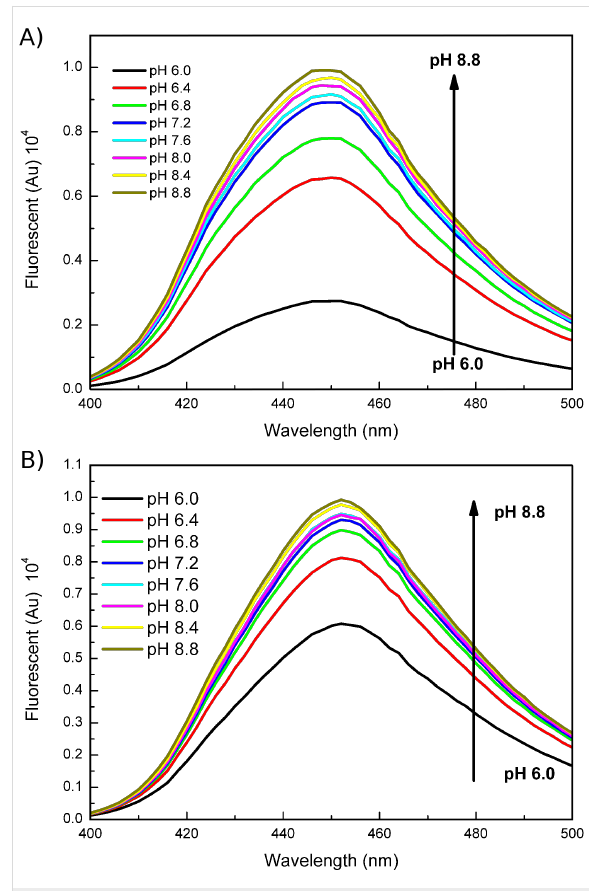
Figure 4: Effect of the pH value of the solution on the fluorescence emission spectra of compounds 1b and 1c . (A) Fluorescence emis- sion spectrum of compound 1b . (B) Fluorescence emission spectrum of compound 1c